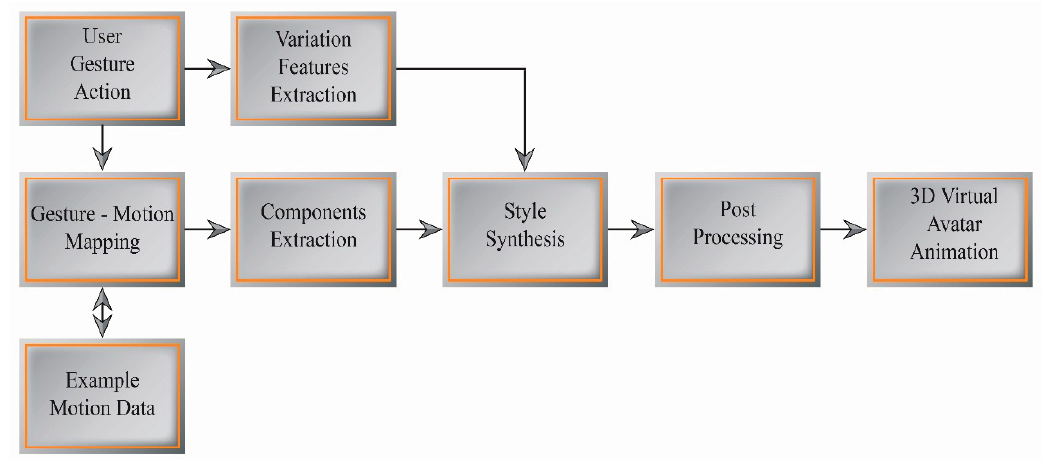
Figure 7. Expressive motion